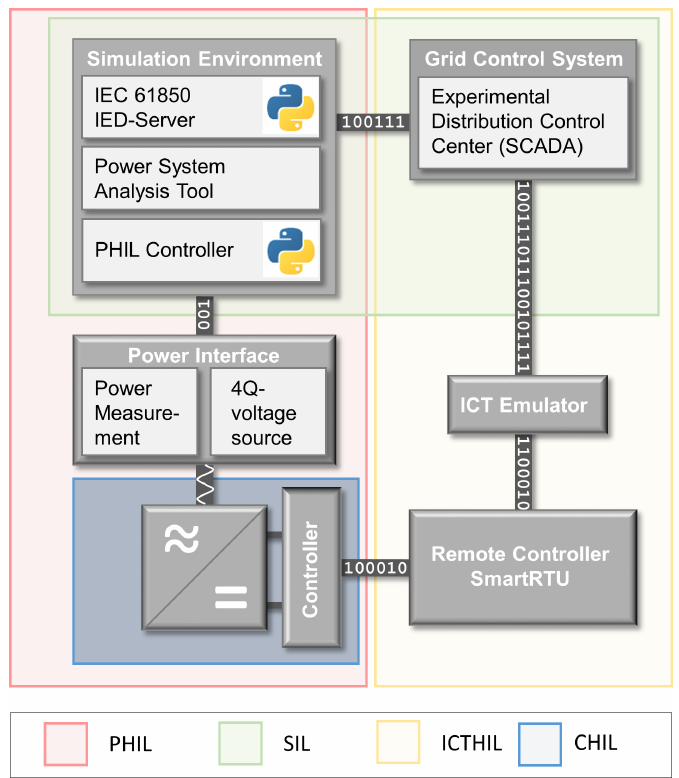
Figure 3. Schematic overview of generic setup for the test and validation of Smart Grid control